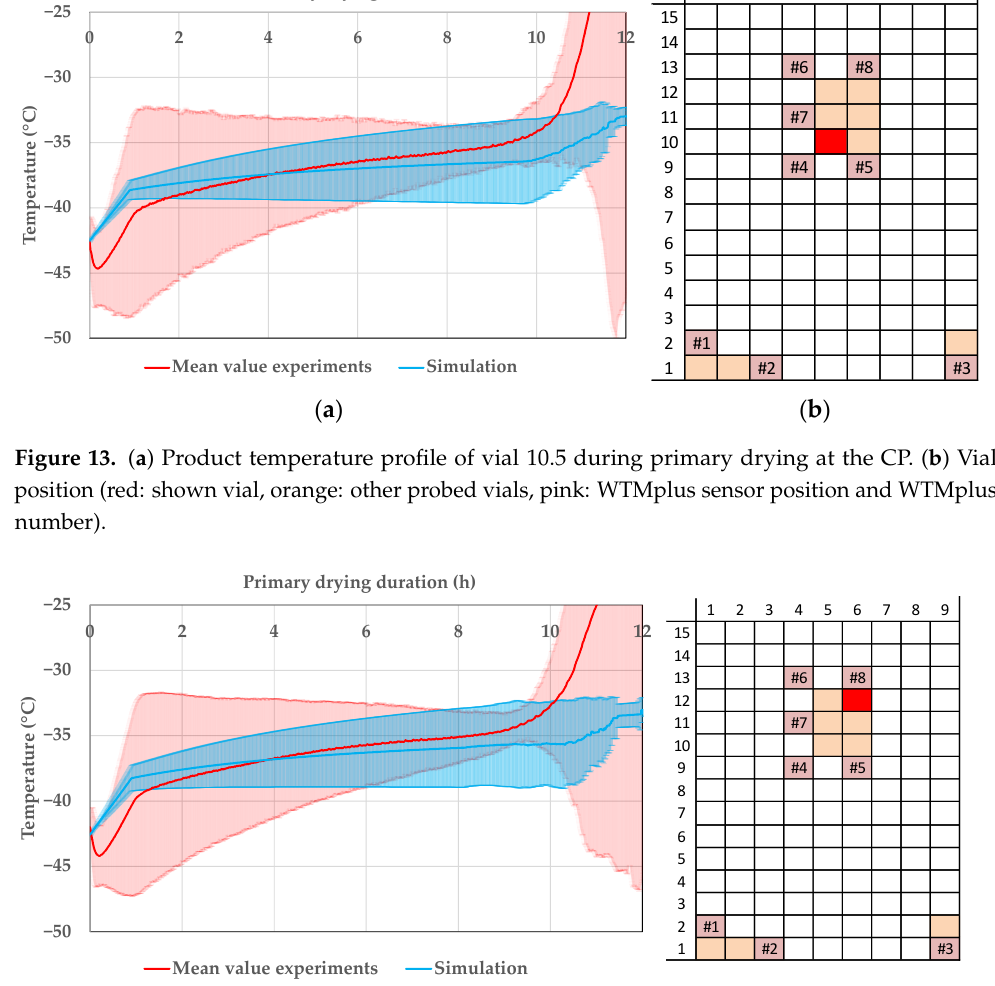
Figure 12. ( a ) Product temperature profile of vial 1.1 during primary drying at the CP. ( b ) Vial po- sition (red: shown vial, orange: other probed vials, pink: WTMplus sensor position and WTMplus number).